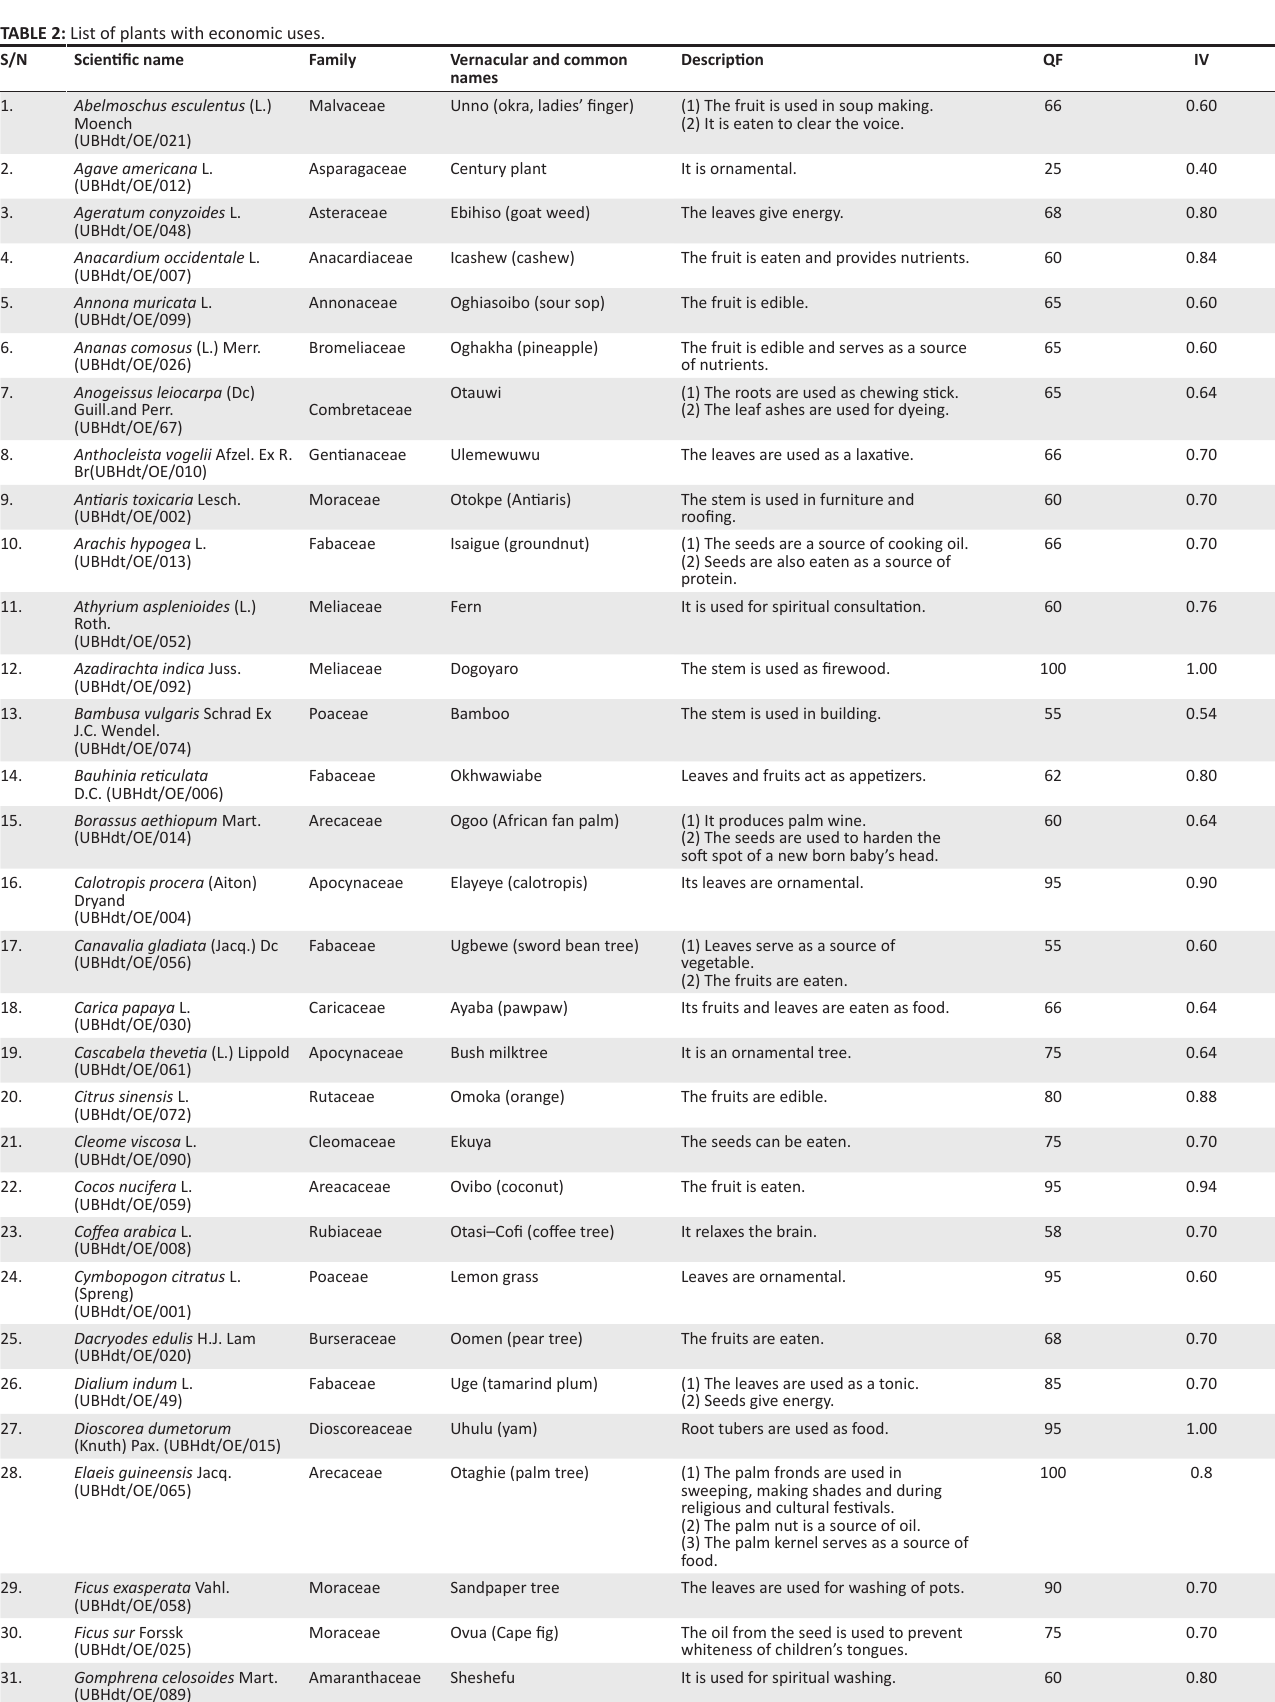
TABLE 2: List of plants with economic